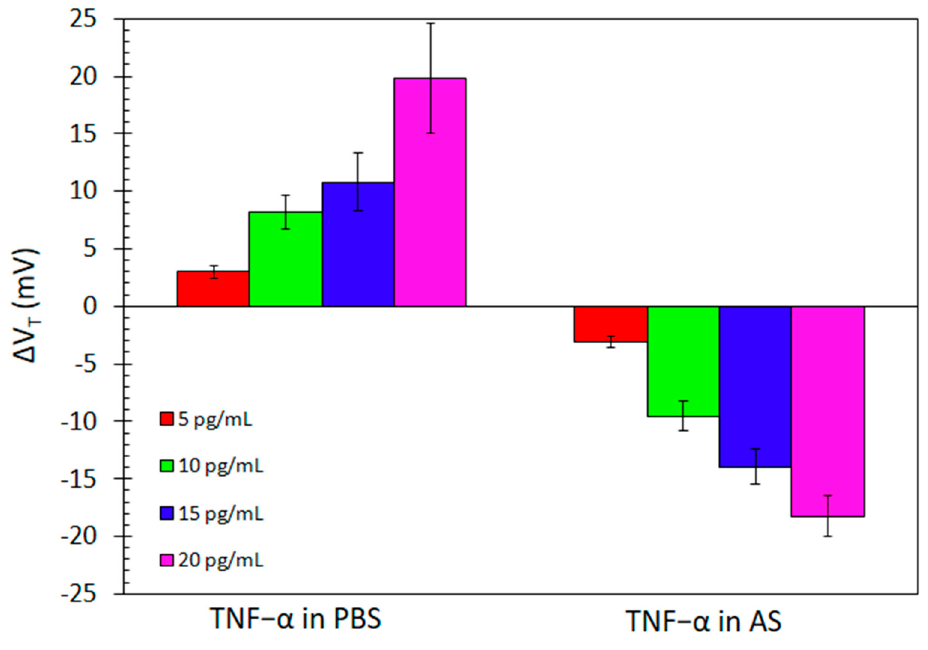
Figure 8. Comparison of ∆ V T of ImmunoFET with immobilized anti-TNF- α mAb for TNF- α detection in PBS and in artificial saliva (AS) under various